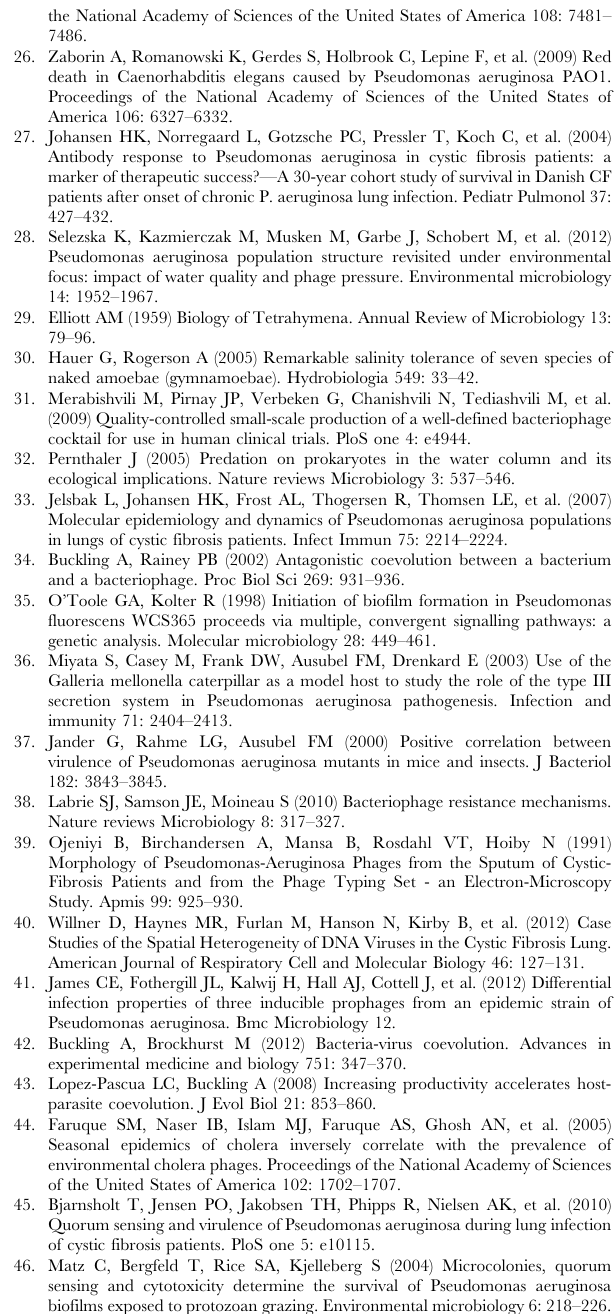
Figure S1 Bacterial growth in the absence and presence of different enemies. The growth of bacteria isolated from patients with intermittent colonisation (a) or chronic (b) CF-lung infection. Panels (c) and (d) show bacterial growth in the absence and presence of different enemies for yellow (c) and white (d) colony type means for chronic CF-patients. Error bars denote 6 1 SEM.